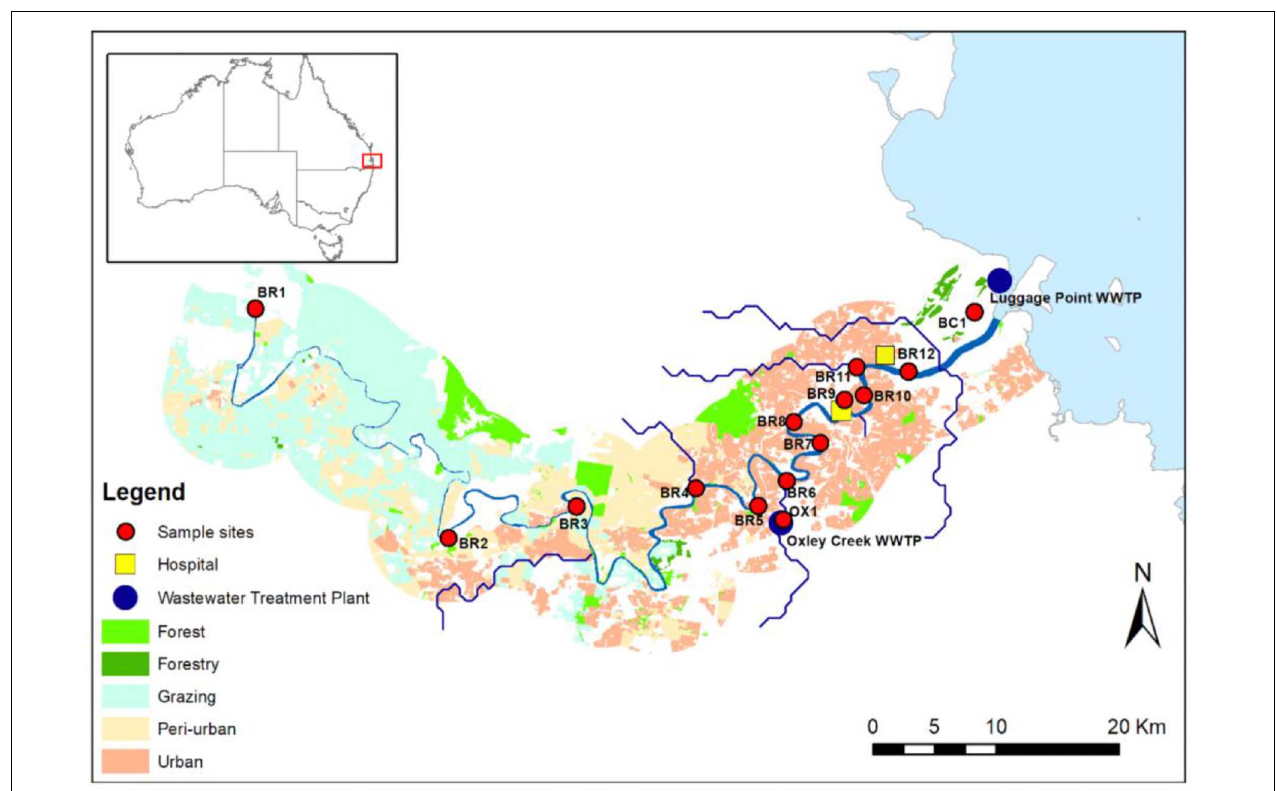
FIGURE 1 | Map of the study sites along the Brisbane River system and its tributaries Oxley Creek, and Boggy Creek, located in Brisbane, Australia. Site OX1 is located downstream of a WWTP, site BR8 is located in proximity to a storm water drain, and sites BR9, BR10, BR11, and BR12 are located downstream of